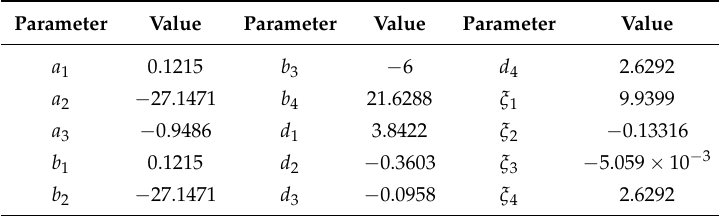
Table 2. Specification of various important